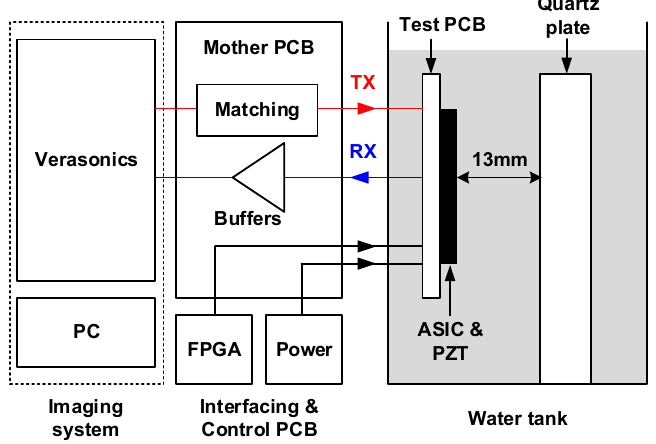
Figure 10. Overview of the measurement setup used for demonstrating the effect of the switching transients for the first- and the second-generation ASICs.